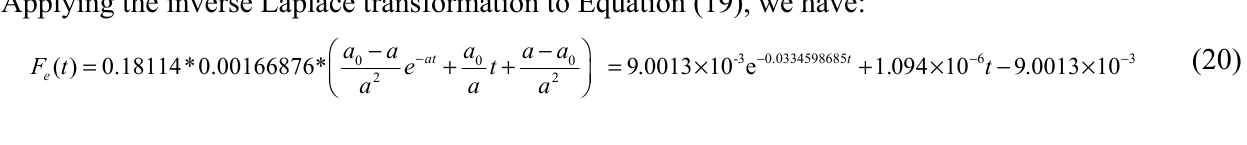
Figure 4. Deflection and distributed bending